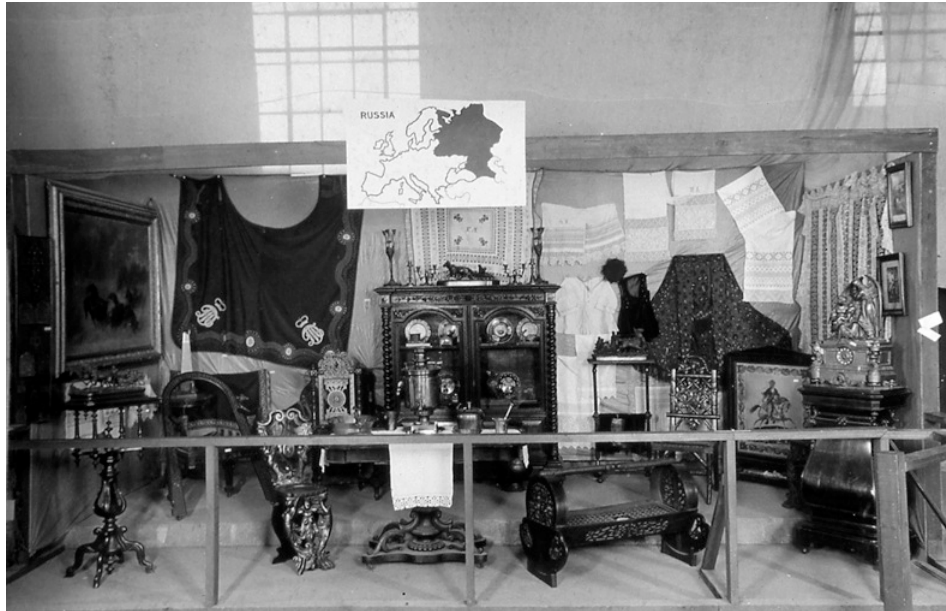
Unknown photographer, Russian booth at the Rochester Arts and Crafts of the Homelands exhibition held April 10-19, 1920 on the grounds of Exposition Park in Rochester, NY. Memorial Art